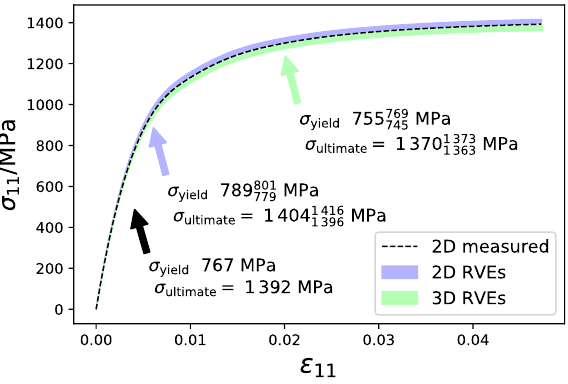
Figure 6. Stress–strain curves in Rolling Direction (RD).